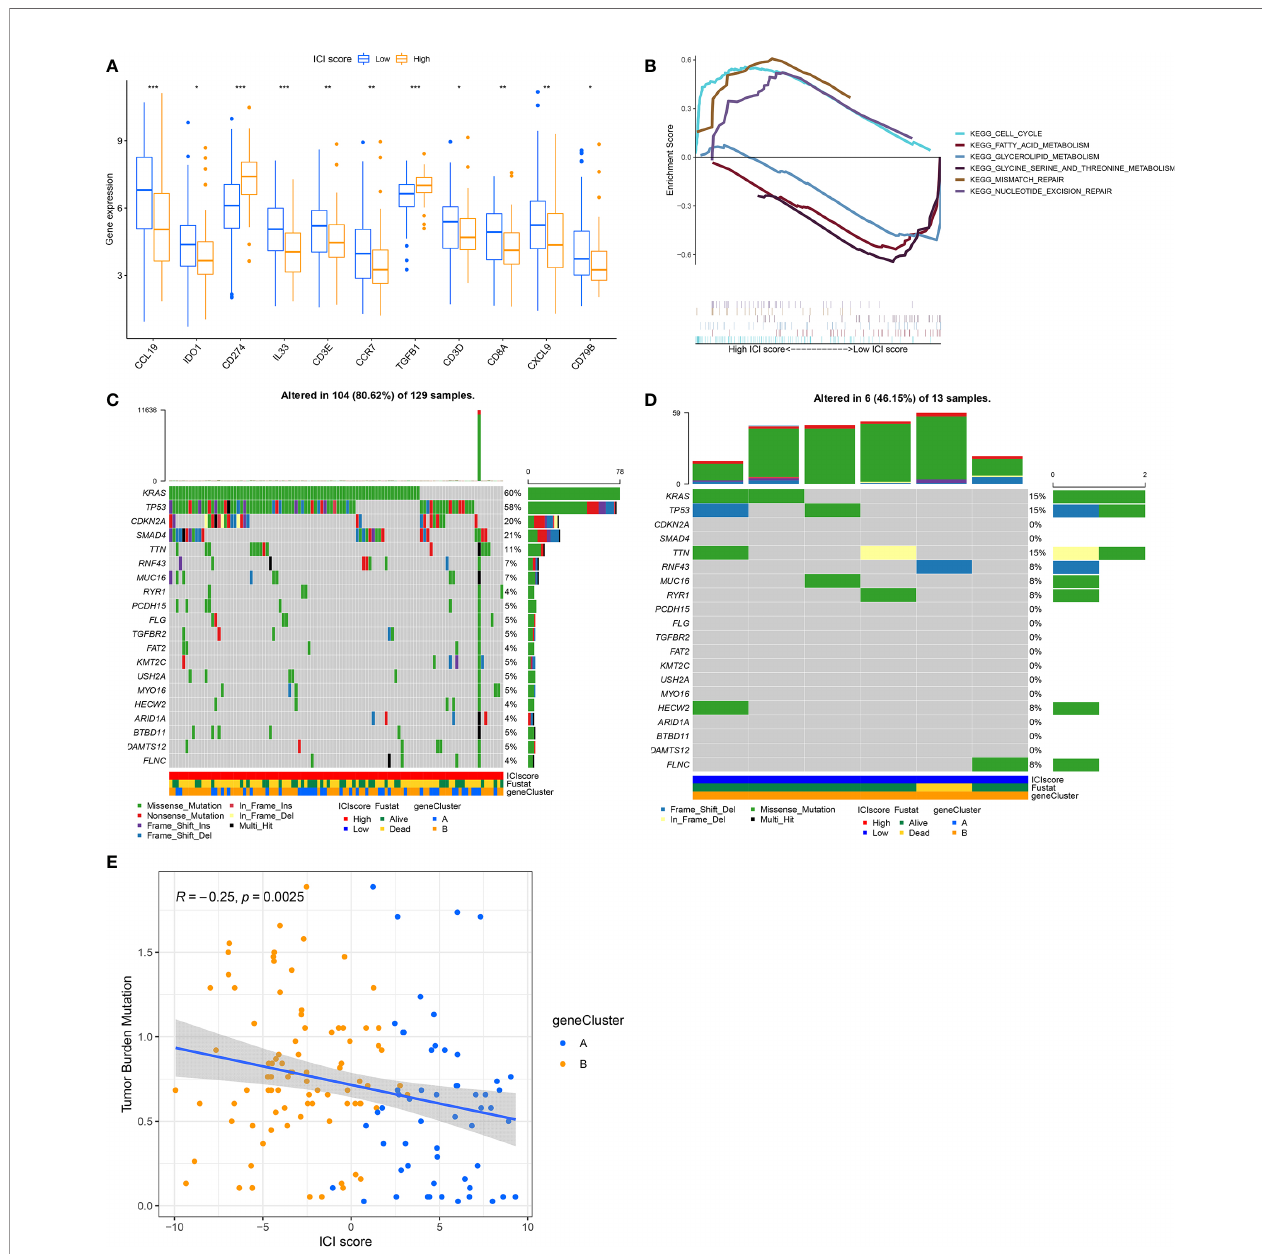
FIGURE 4 | The ICI Score Generation and Association between the ICI Scores and Somatic Variants. (A) Evaluation of the immune-checkpoint-related genes and immune-activation-related genes in high and low ICI score subgroups. Signi fi cance was computed using the Wilcoxon test, * P < 0.05; ** P < 0.01; *** P < 0.001. (B) Enrichment plots reveal that the cell cycle and DNA repair pathways were signi fi cantly enriched and activated in the high ICI score group, relative to the low ICI group. Conversely, three metabolism signaling pathways (glycerolipid metabolism; fatty acid metabolism; glycine, serine and threonine metabolism) were signi fi cantly enriched and inhibited in the low ICI score group, relative to the high ICI group. (C, D) The oncoPrint was compiled, based on a high ICI score (C) and low ICI score (D) . Each column represents a single patient. (E) Scatter plots illustrating a negative association between the ICI score and mutation load in the TCGA cohort. The Spearman correlation between ICI scores and mutation load is also provided ( P =